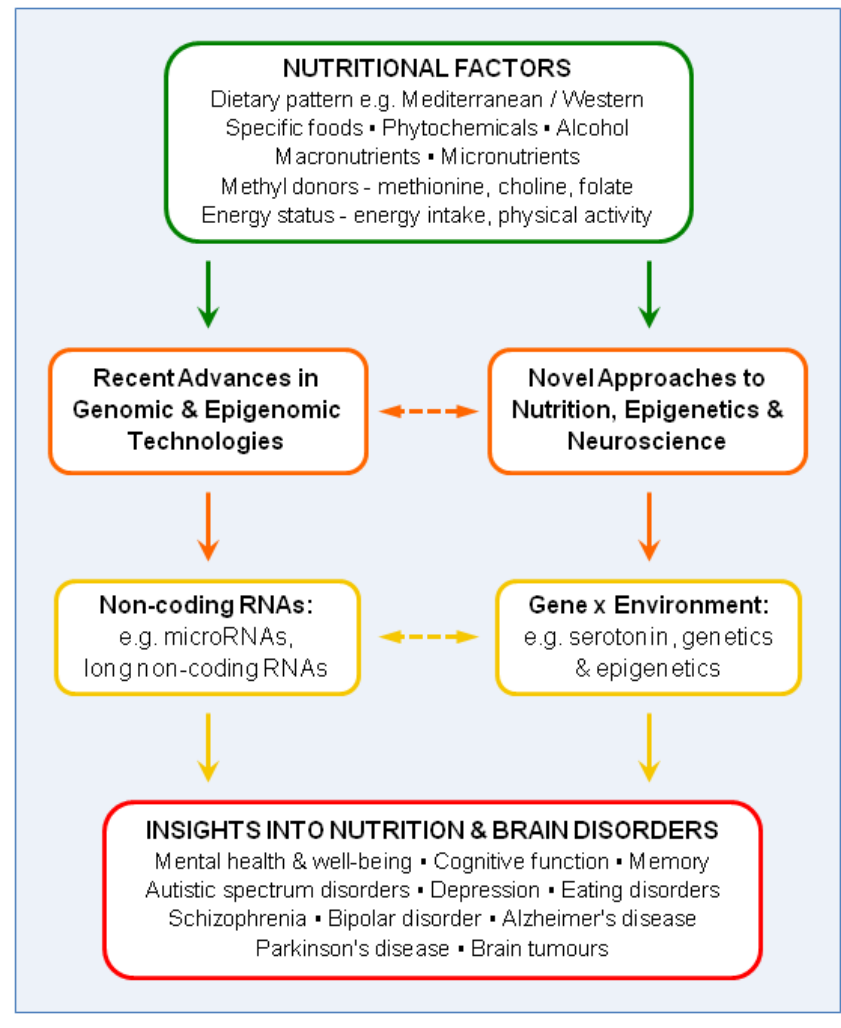
Figure 1. Nutrition-gene interactions and brain disorders: Outline of current